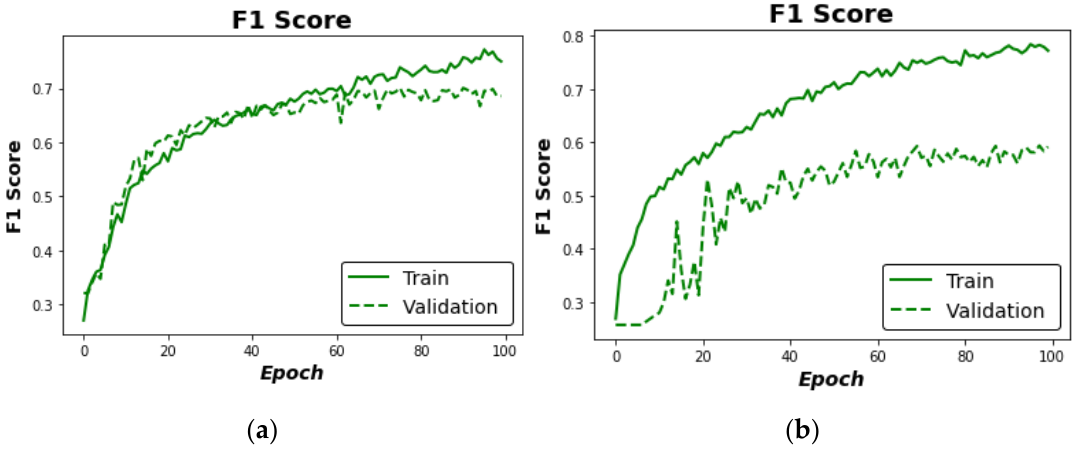
Figure 19. ( a ) U-Net with spatial dropout F1 curve; ( b ) DeepLabV3+ with spatial dropout F1 curve.